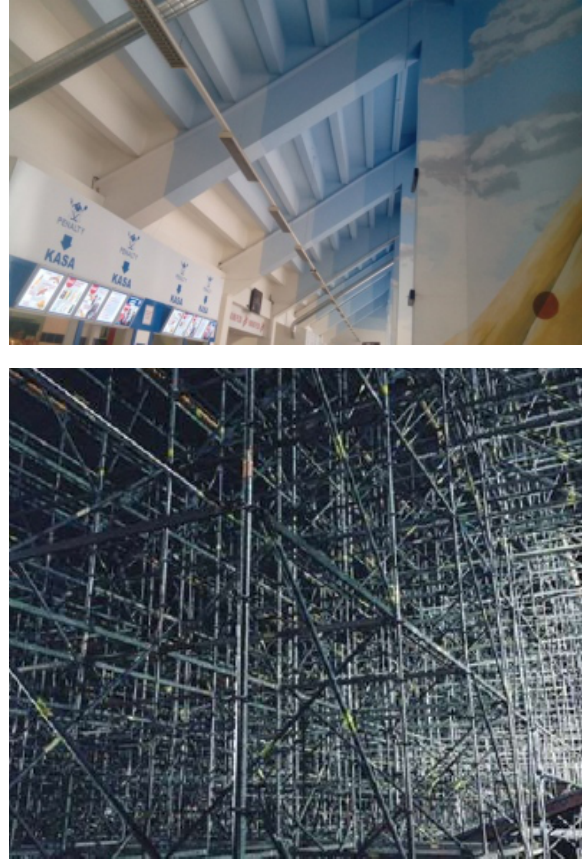
Figure 4. Construction of monitored grandstands: Ice-hockey stadium – Pilsen (upper) [5], Biathlon sta- dium – New Town in Moravia (lower) [4].